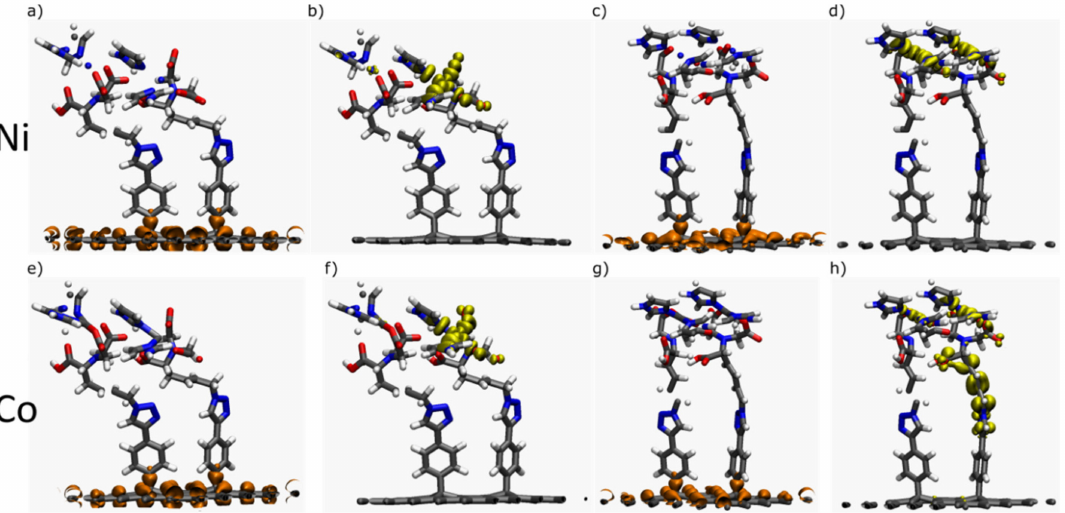
Figure 6. Shapes of HOCO (orange) and LUCO (yellow) molecular orbitals for (Ni-1DB) 2 ( a , b ), (Ni-2DB) 2 ( c , d ), (Co-1DB) 2 ( e , f ) and (Co-2DB) 2 ( g , h ). For DOS projected over onto corresponding fragments see Supplementary Materials (Figures